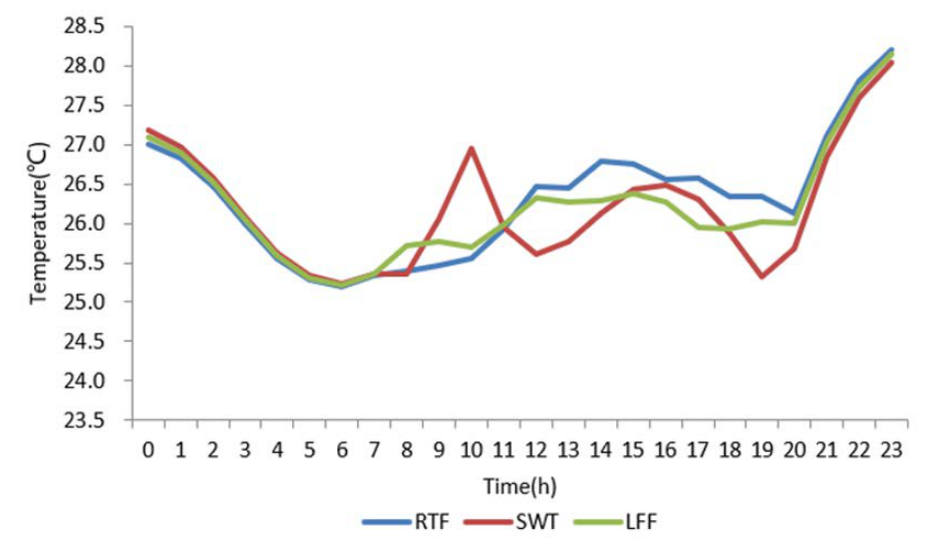
Figure 12. Comparison of room temperature under different control strategies on 19th June .